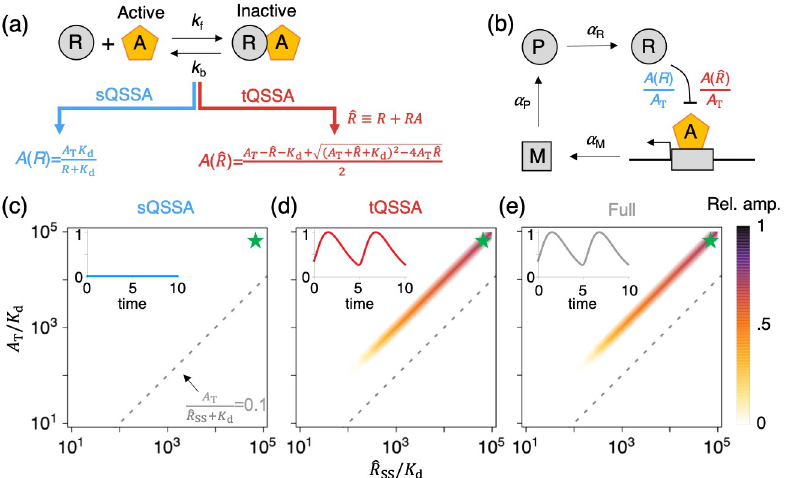
Fig 3. sQSSA, but not tQSSA, leads to the false suppression of oscillations in a protein sequestration–based transcriptional negative feedback loop. (a) A repressor protein (R) inhibits its own transcriptional activator (A) by forming a 1:1 stoichiometric complex (RA). The QSS of the free activator, which is not sequestered by the repressor, can be approximated with either the sQSSA or the tQSSA. As the QSSA is derived from reversible binding without any conversion rate, the dissociation constant K d = k b / k f is used instead of the Michaelis constant K M . (b) In the transcriptional negative feedback loop, where the repressor protein sequesters the activator protein, the transcription of the repressor’s mRNA is assumed to be proportional to the fraction of total activator that is free (i.e., A / A T ), which can be approximated by either the sQSSA or the tQSSA (a). M, mRNA; P, encoded protein; R, repressor protein; A, activator; RA, repressor–activator complex; ^ R , repressor + repressor–activator complex, A T , activator + repressor– activator complex. (c–e) Heat maps of the relative amplitude of simulated trajectories of M . Oscillations are not possible for the sQSSA model (c). On the other hand, when the validity condition for the sQSSA does not hold (i.e., above the gray dashed line), both the tQSSA (d) and the full (e) models simulate oscillations. In these calculations, A T and α M are varied so that ^ R = K (where ^ R is the steady-state value of ^ R ) varies between 10 and 10 5 . Furthermore, k f SS d SS = k b = 10 (i.e., K d = 1) and all other parameter values = 1. Insets: for a particular choice of parameter values (star mark), trajectories of M are simulated, and all trajectories are normalized by the maximum value of the trajectory simulated by the full model. QSS, quasi-steady state; sQSSA, standard quasi-steady state approximation; tQSSA, total quasi- steady state